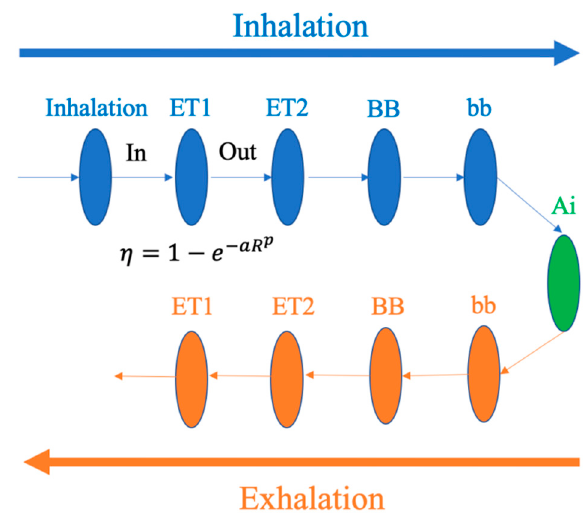
Figure 4. Lung compartments treated as filters in the International Commission on Radiological Protection 66 (ICRP66) lung model [4].